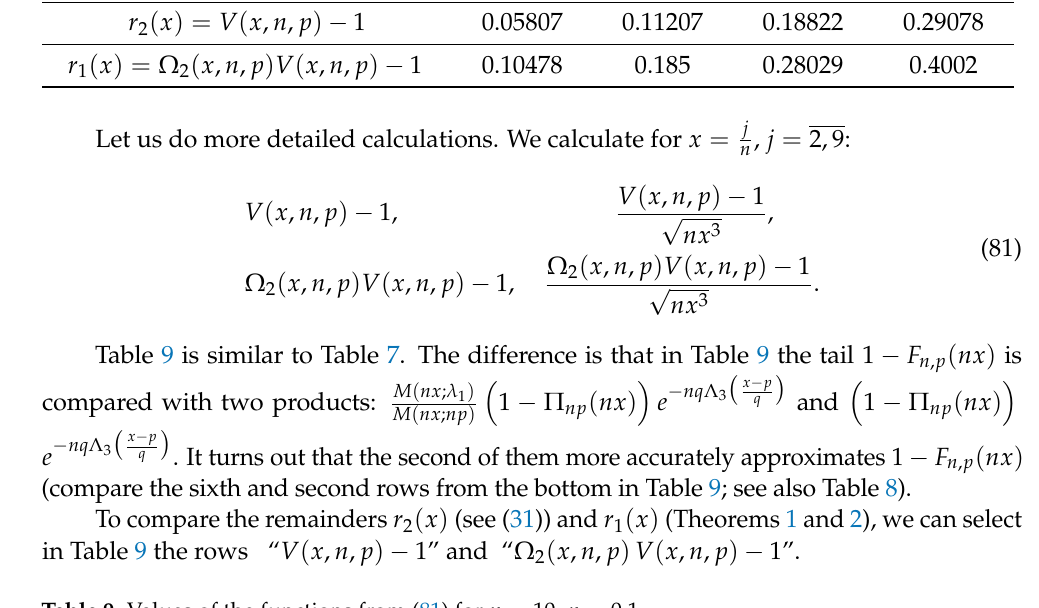
Table 9. Values of the functions from (81) for n = 10, p =